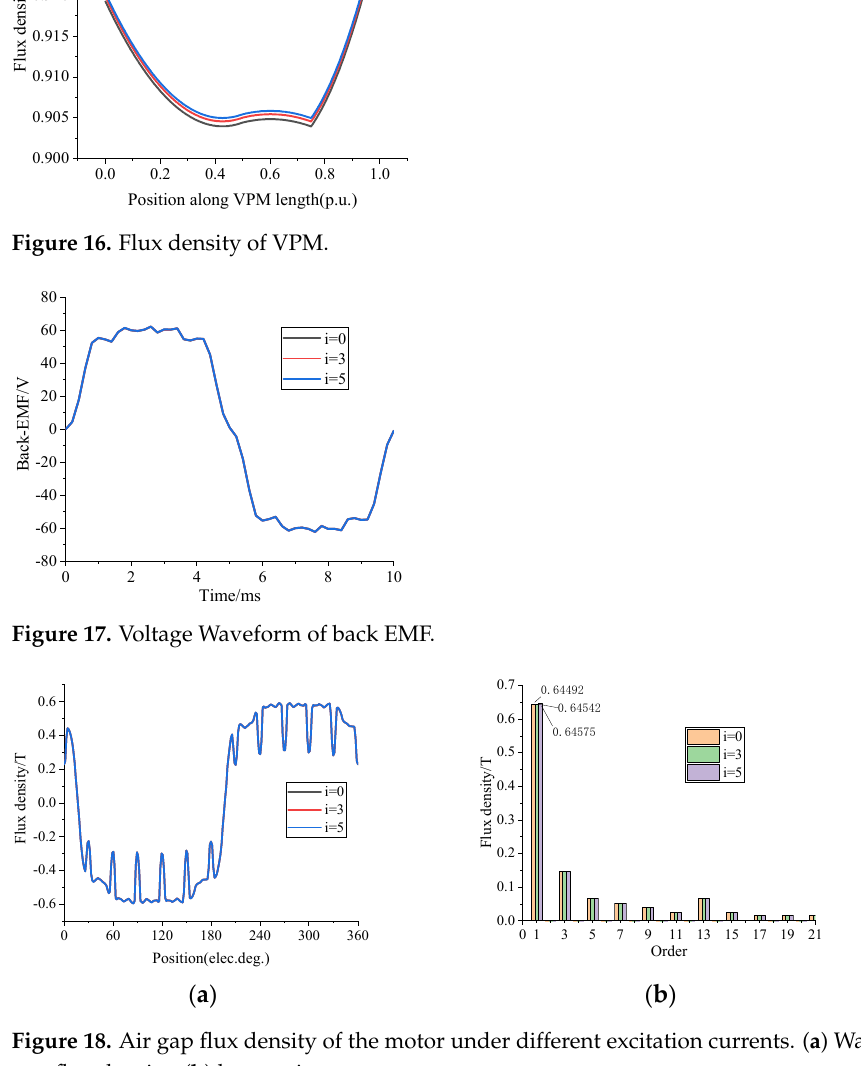
Figure 18. Air gap flux density of the motor under different excitation currents. ( a ) Waveform of air gap flux density; ( b ) harmonic spectra.